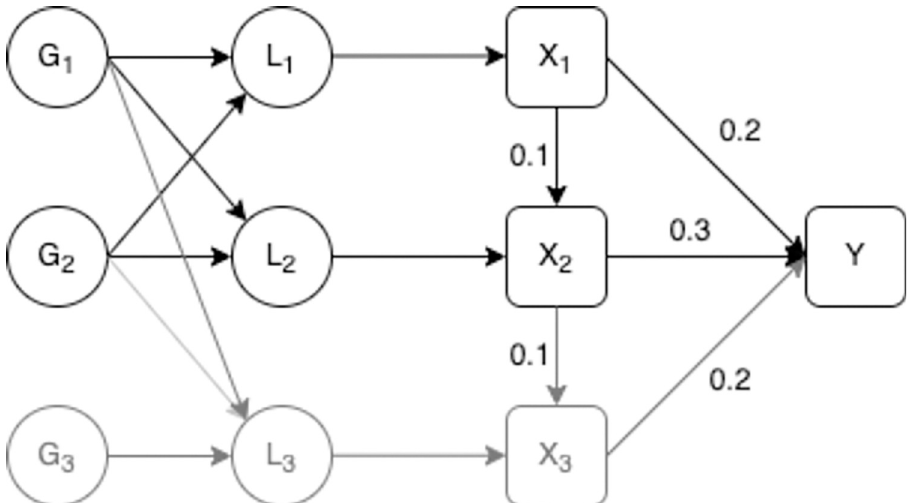
Fig 4. Model with three liability time periods. – L 1 is the liability of the exposure in the first time period, L 2 is the liability of the exposure in the second period, L 3 is the liability of the exposure in the third period, G 1 is a set of genetic variants associated with L 1 , L 2 and L 3 , G 2 is another set of genetic variants associated with L 1 , L 2 and L 3 and G 3 is a set of genetic variants associated with L 3 . X 1 and X 2 are observed values of the exposure, where X 2 is observed at a later point in an individual’s life than X 1 . X 3 is a third value of the exposure, X 3 , L 3 and G 3 are given in grey to illustrate that although they have an effect on the outcome they are not included in the estimation. Y is an outcome. X 1 , X 2 , X 3 and Y are confounded by a set of unobserved confounders U . X 1 , X 2 and X 3 are measured with error, this measurement error is uncorrelated with the genetic variants. The direct causal effect of X 1 on X 2 and Y , X 2 on X 3 and Y , and X 3 on Y are given on the